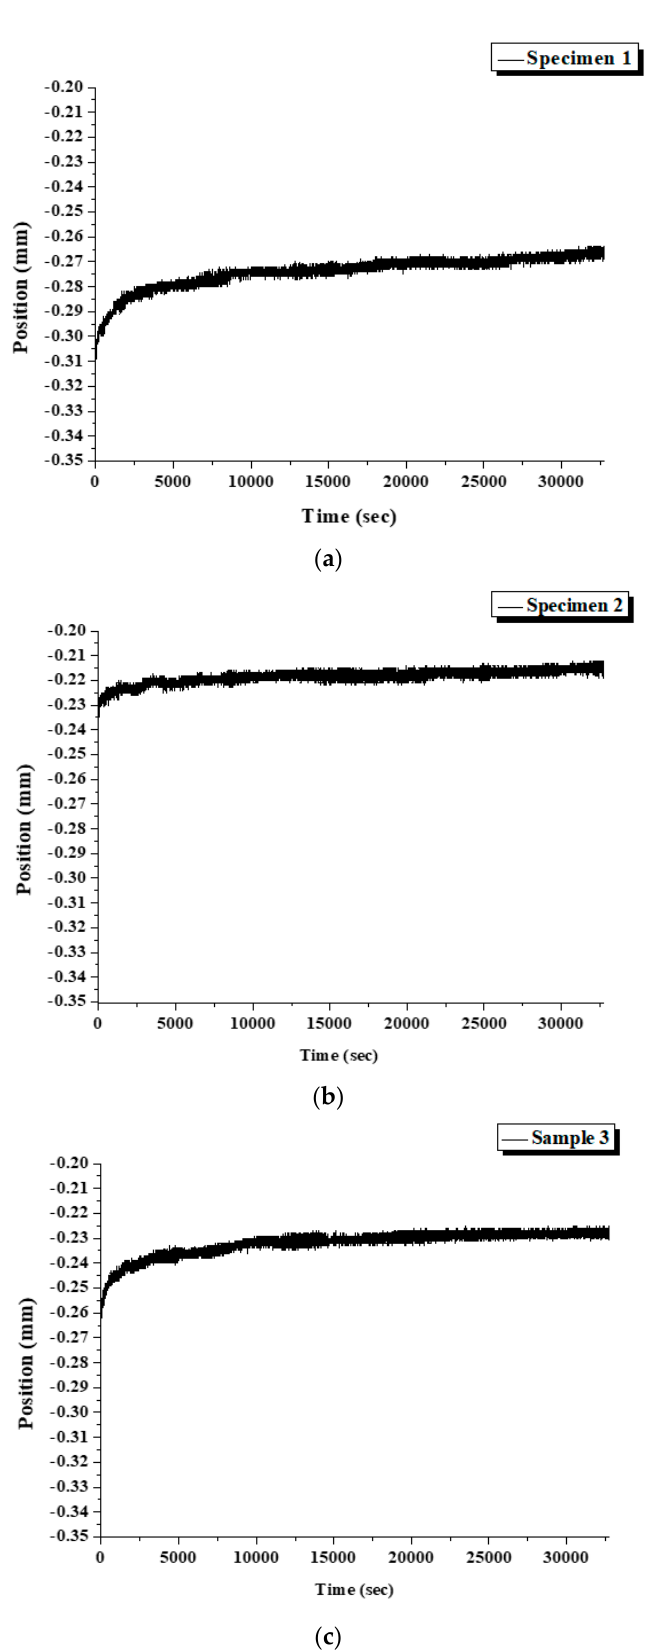
Figure 17. The displacement of specimens during the test. ( a ) Specimen 1, ( b ) Specimen 2, ( c ) Specimen 3.